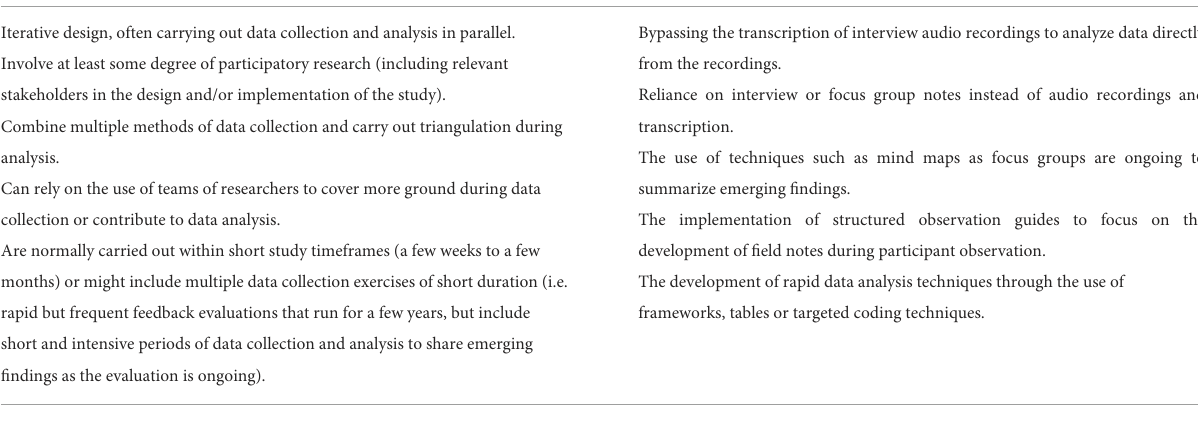
TABLE 1 Characteristics and approaches of rapid qualitative research (Vindrola-Padros,